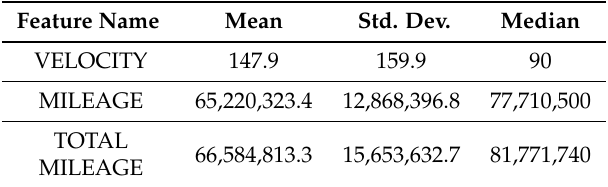
Table 2. Descriptive statistics on features used for training